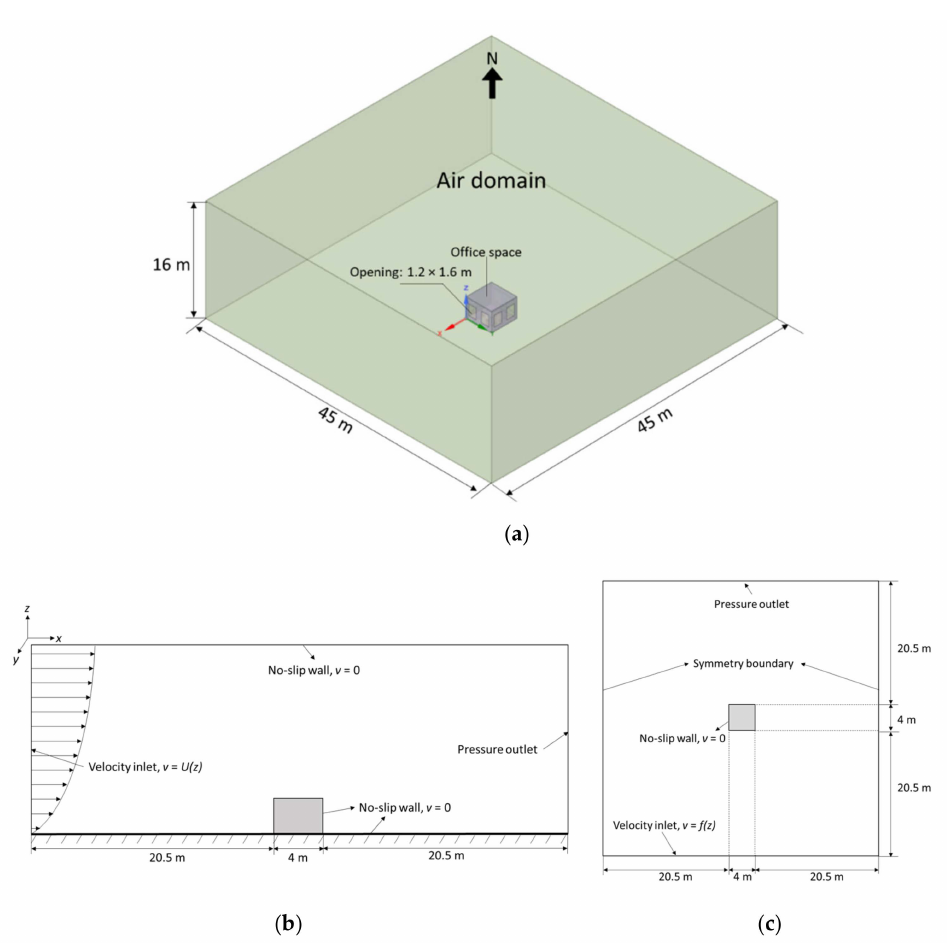
Figure A1. Design conditions for simulation of natural ventilation illustrating various do- mains: ( a ) Computational domain, ( b ) Boundary conditions: side view, and ( c ) Boundary conditions: top view.